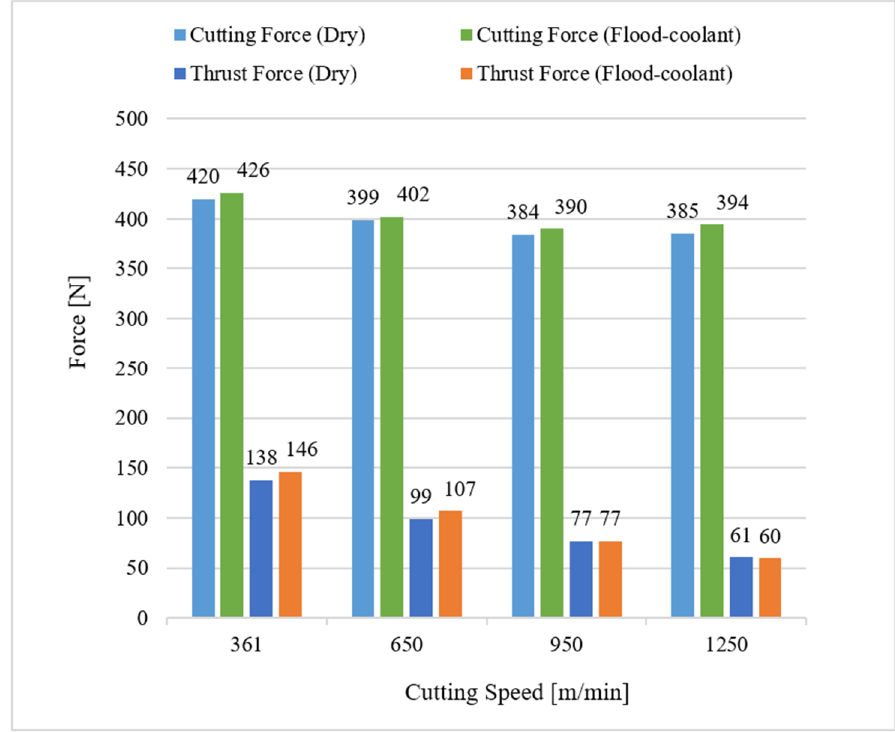
Figure 5. Variation of cutting and thrust forces with cutting speed in dry and flood-coolant modes.